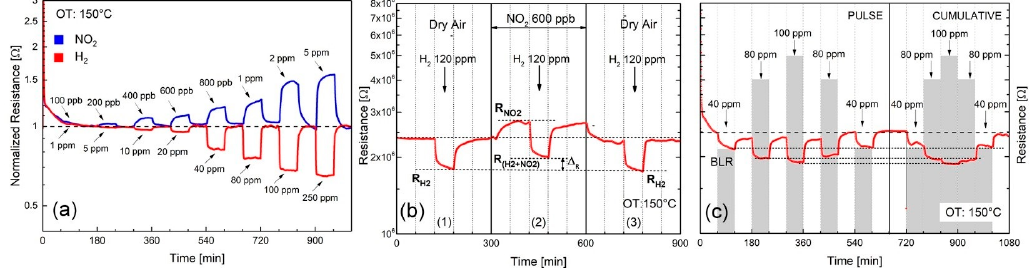
Figure 8. Electrical responses of the exfoliated WS 2 post-annealed at 180 °C, at 150 °C operating temperature in dry air. ( a ) Comparison of the normalized dynamic response to NO 2 (100 ppb–5 ppm) and H 2 (1–250 ppm), ( b ) NO 2 cross-sensitivity to H 2 : first panel, the response to 120 ppm H 2 in dry air, second panel, response to 120 ppm H 2 with 600 ppb NO 2 , third panel, response to 120 ppm H 2 (as to first panel) for comparison, ( c ) Reproducibility and baseline recovery by exposing the film to both pulse and cumulative H 2 concentrations in the range 40–100 ppm. H 2 concentrations are highlighted in the figure by grey shadowed rectangular plots.